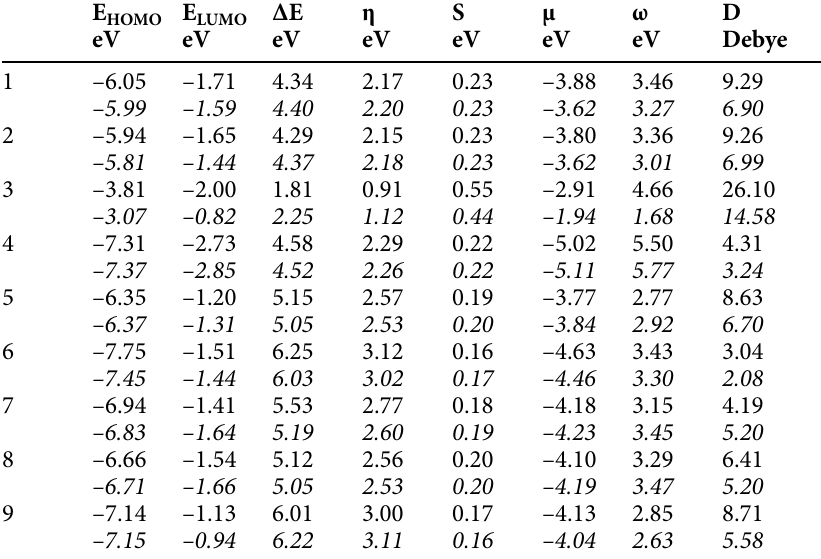
Table 1. Global descriptors: hardness (η), chemical potential (µ), electrophilic index (ω), softness (S), frontier orbitals energies (E HOMO , E LUMO ) and dipole moments (D) of drugs, (values in italic